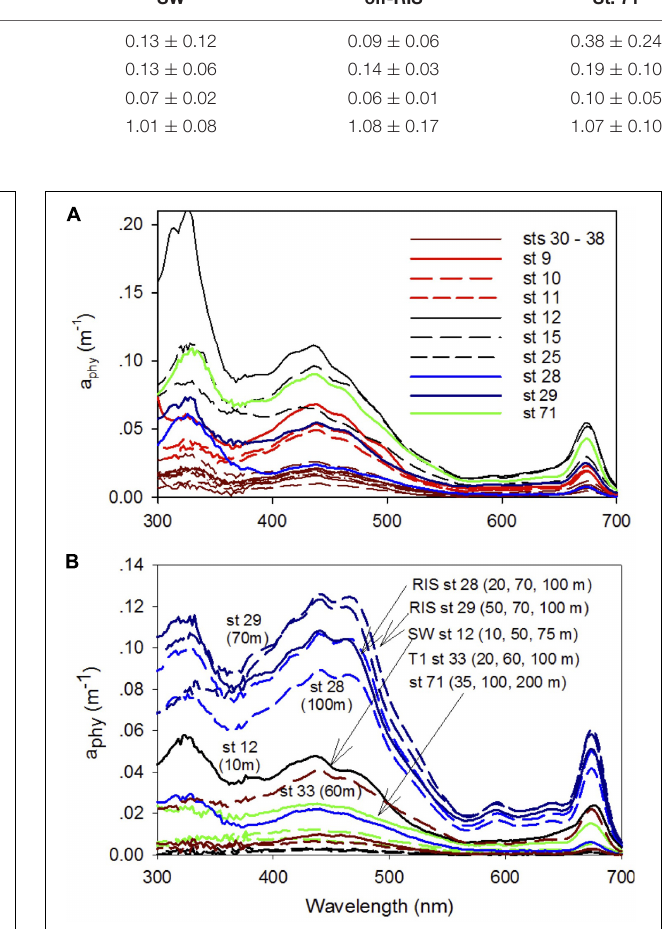
TABLE 2 | Mean of the three fluorescence components (RU) identified by the PARAFAC model and the biological index BIX in the Ross Sea and the three regions (NW + T1, SW, off-RIS) and station 71 located north of the Ross Island. Property Ross Sea NW + T1 SW off-RIS St. 71